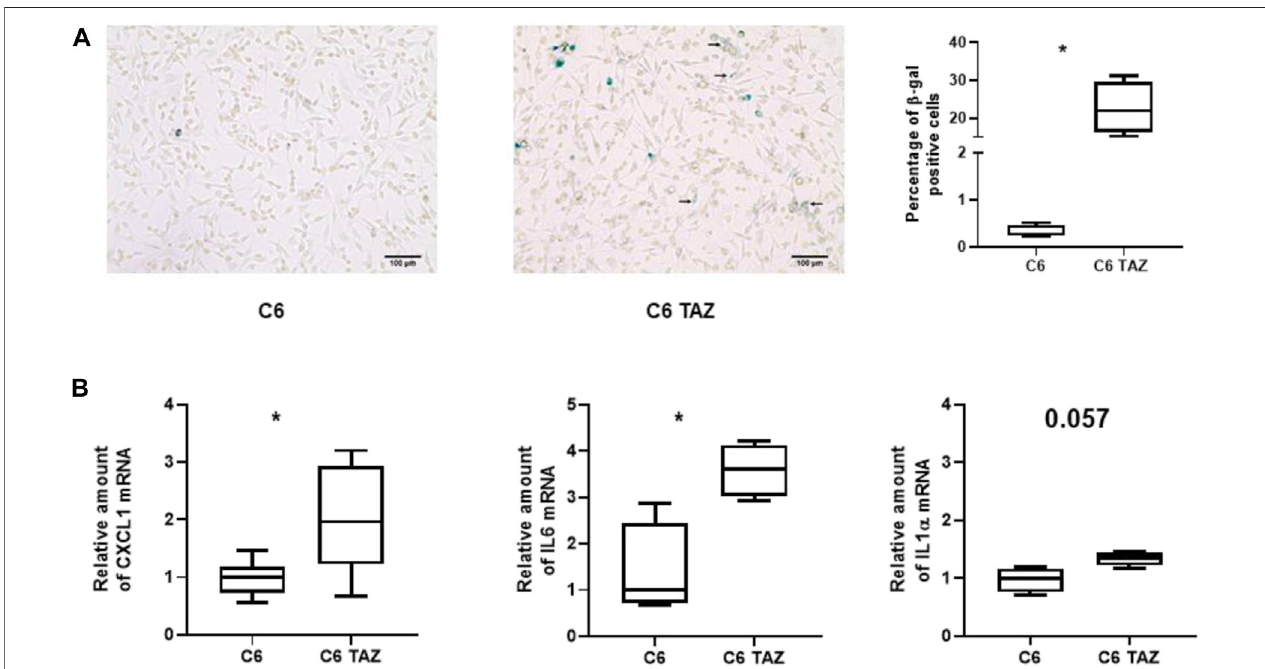
FIGURE 5 | (A) Left: Microscopic images of β -gal positive cells (blue color) in C6 and C6 TAZ cells. Right: Percentage of β -gal positive cells is given as boxplot (*indicates p < 0.05). (B) UpregulationofSASPgenes:Amountsofmrnas ofCXCL1, IL6, andIL1 α areelevated inC6TAZ cells(mrnaexpression normalizedtoRPL13a; n = 4, p =